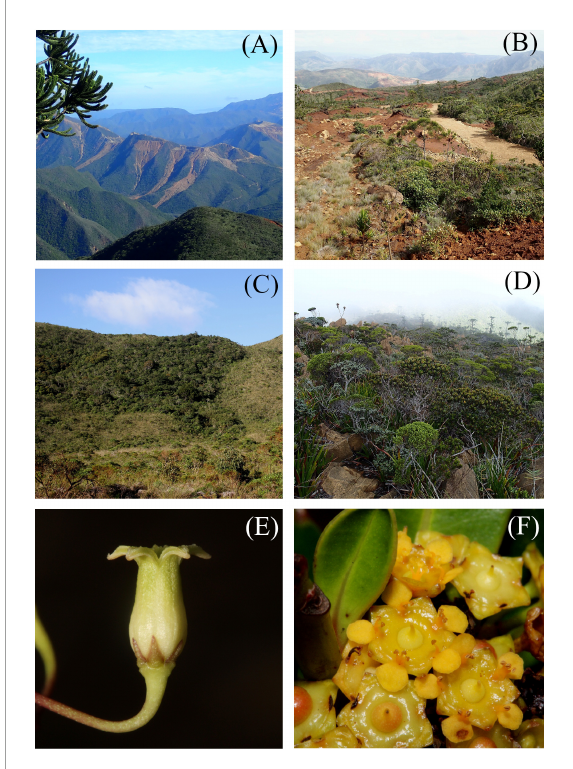
FIGURE1 Mining landscape in the northwest (A) and details of a degraded mid-altitude (ca. 600 m a.s.l) shrubland (B) , low-altitude (ca. 200 m a.s.l.) forest remnants (C) , a high altitude (ca. 1,400 m a.s.l.) well-conserved shrubland (D) and two species identified as